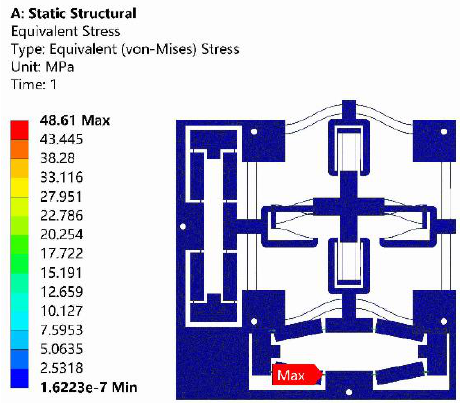
Figure 13. Analysis of the output stiffness by ANSYS.